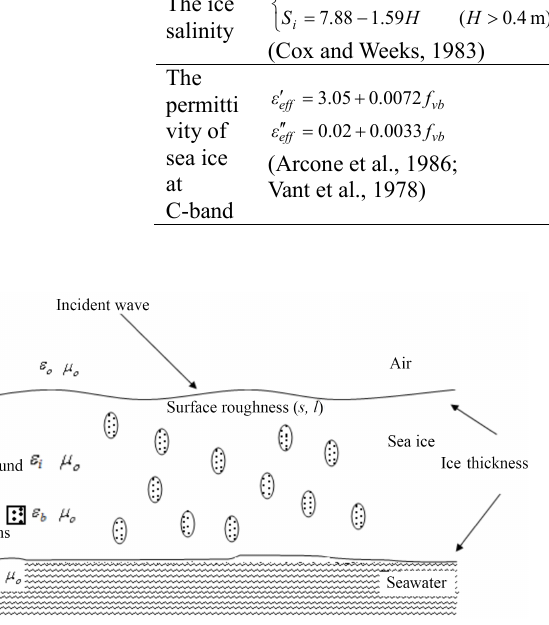
Figure 3. Structure and geometric model of the configuration of sea